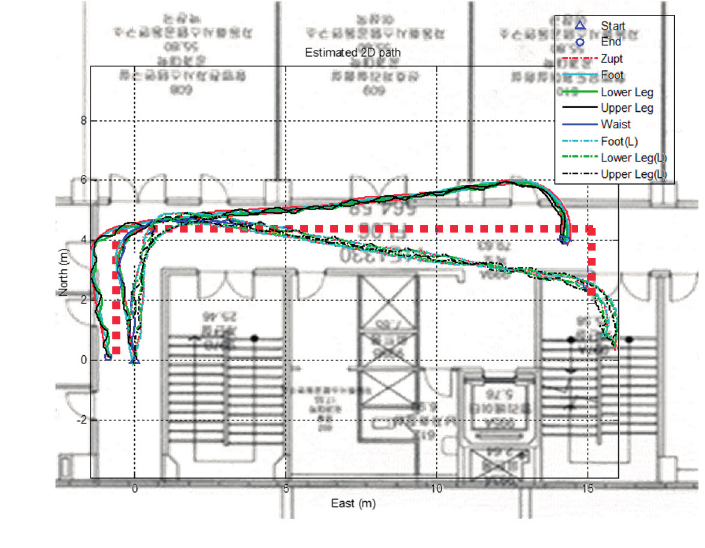
Figure 9. Result of PDR using foot-mounted IMU applied at dual foot. The solid line is position of right leg segments and the dotted line is position of left leg